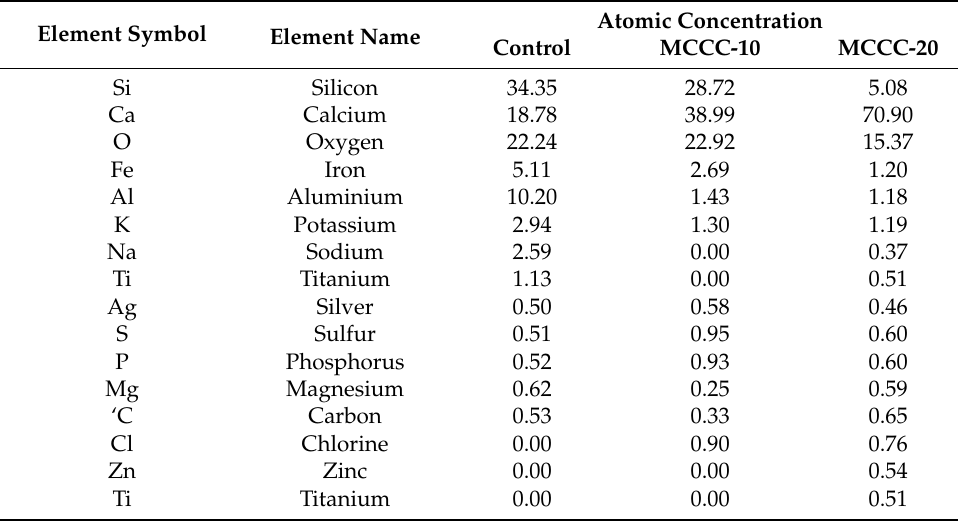
Figure 15. ( a , b ) SEM images of MCCC-20 HPC at 90 days. Table 5. Oxides Atomic Concentration of the HPCs from